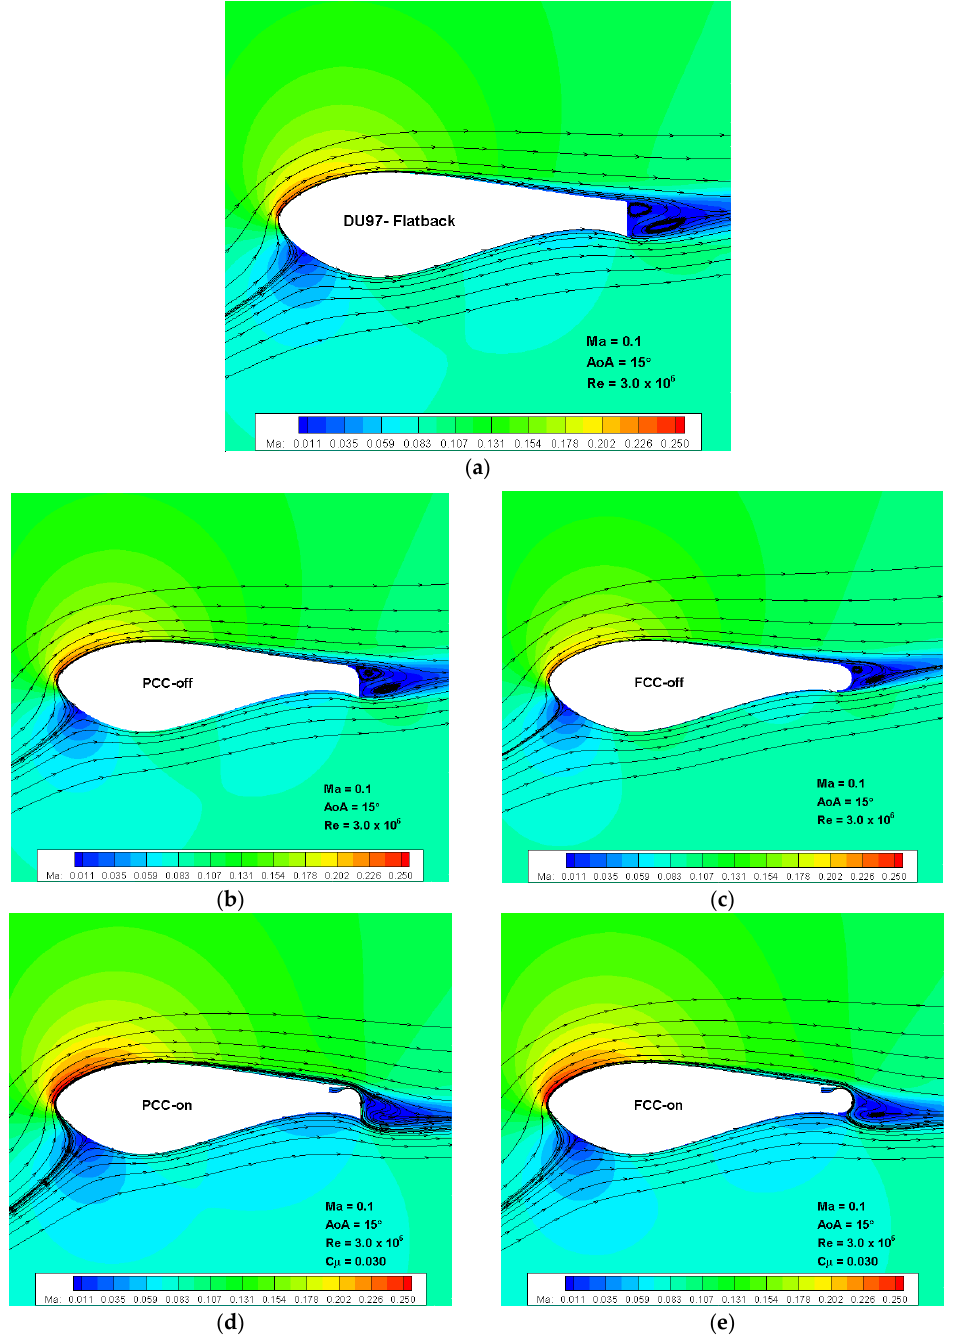
Figure 11. Flow fields of different cases at AoA = 15°: ( a ) DU97-Flatback; ( b ) PCC-off; ( c ) FCC-off; ( d ) PCC-on; ( e ) FCC-on.